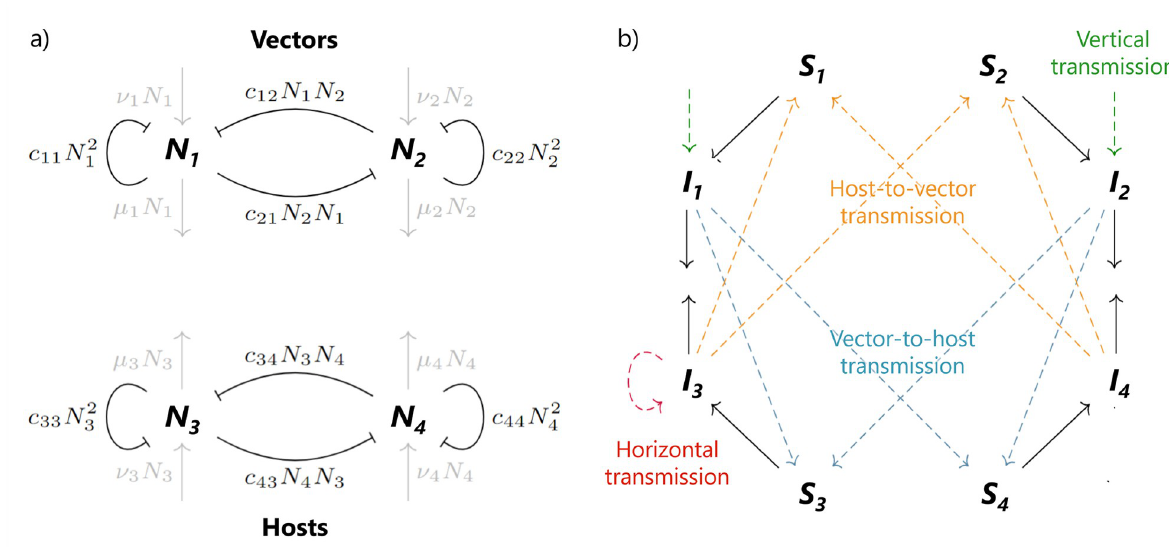
Fig 1. Diagrams of the ecological (a) and epidemiological (b) components of the model. Gray arrows: demography related movements, t-bars: competition, black arrows: infection related transitions, dashed arrows: transmission routes (green: vertical, yellow: host-to-vector, blue: vector-to- host, red: